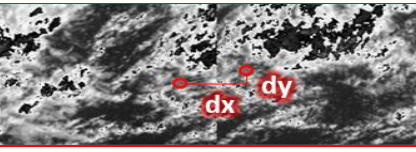
Figure 7. Estimated translation parameters through frequency matching